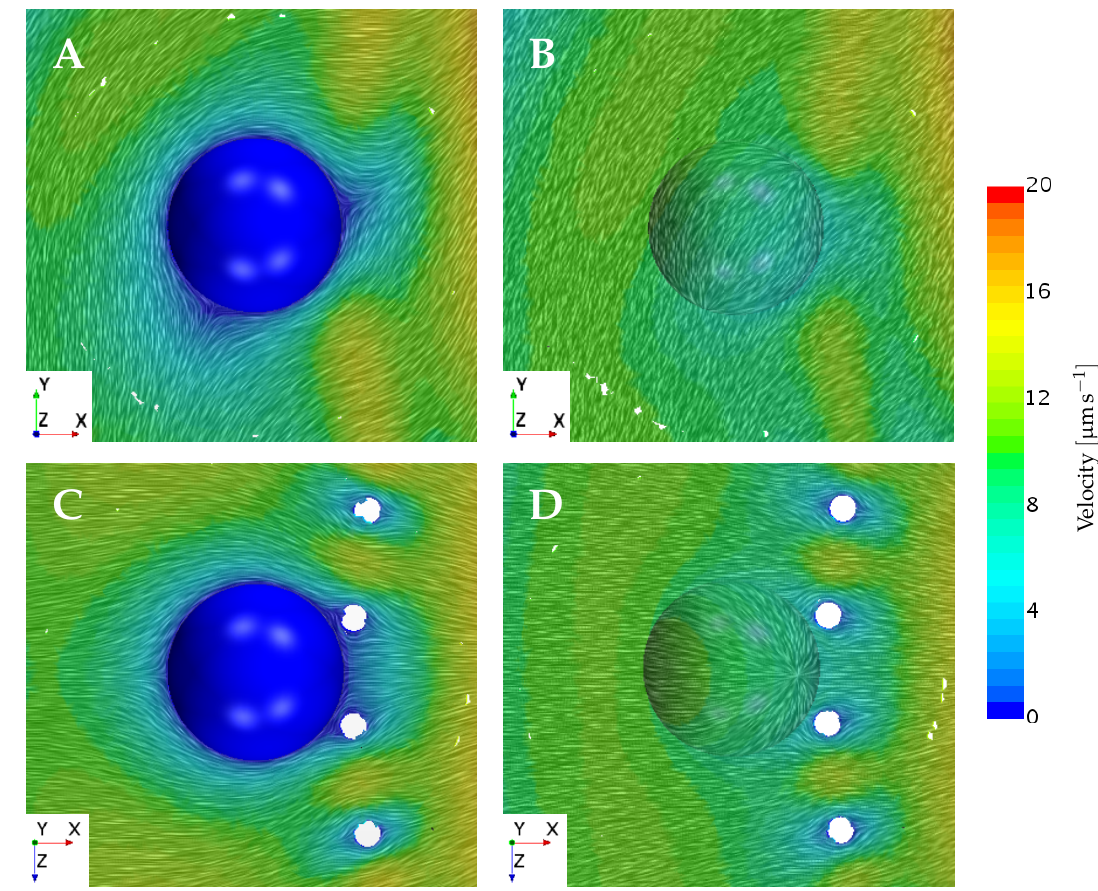
Figure 9. Planar views of the flow field velocity near a prey, showing the differences between the static and dynamic simulation approaches. Pictured is the large prey positioned on the left side of the filter around the middle (Prey the local prey coordinate system. All figures show the instantaneous flow field corresponding to the flagellum position pictured in Figure 1. ( A ) The local flow field seen from a frontal perspective when the prey is fixed. ( B ) The local flow field seen from a frontal perspective when the prey freely drifts. ( C ) The local flow field seen from a top perspective when the prey is fixed. ( D ) The local flow field seen from a top perspective when the prey freely